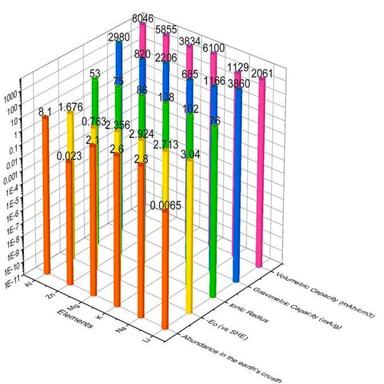
Comparison of some elements used in battery technology in terms of resource abundance and electrochemical functionality.